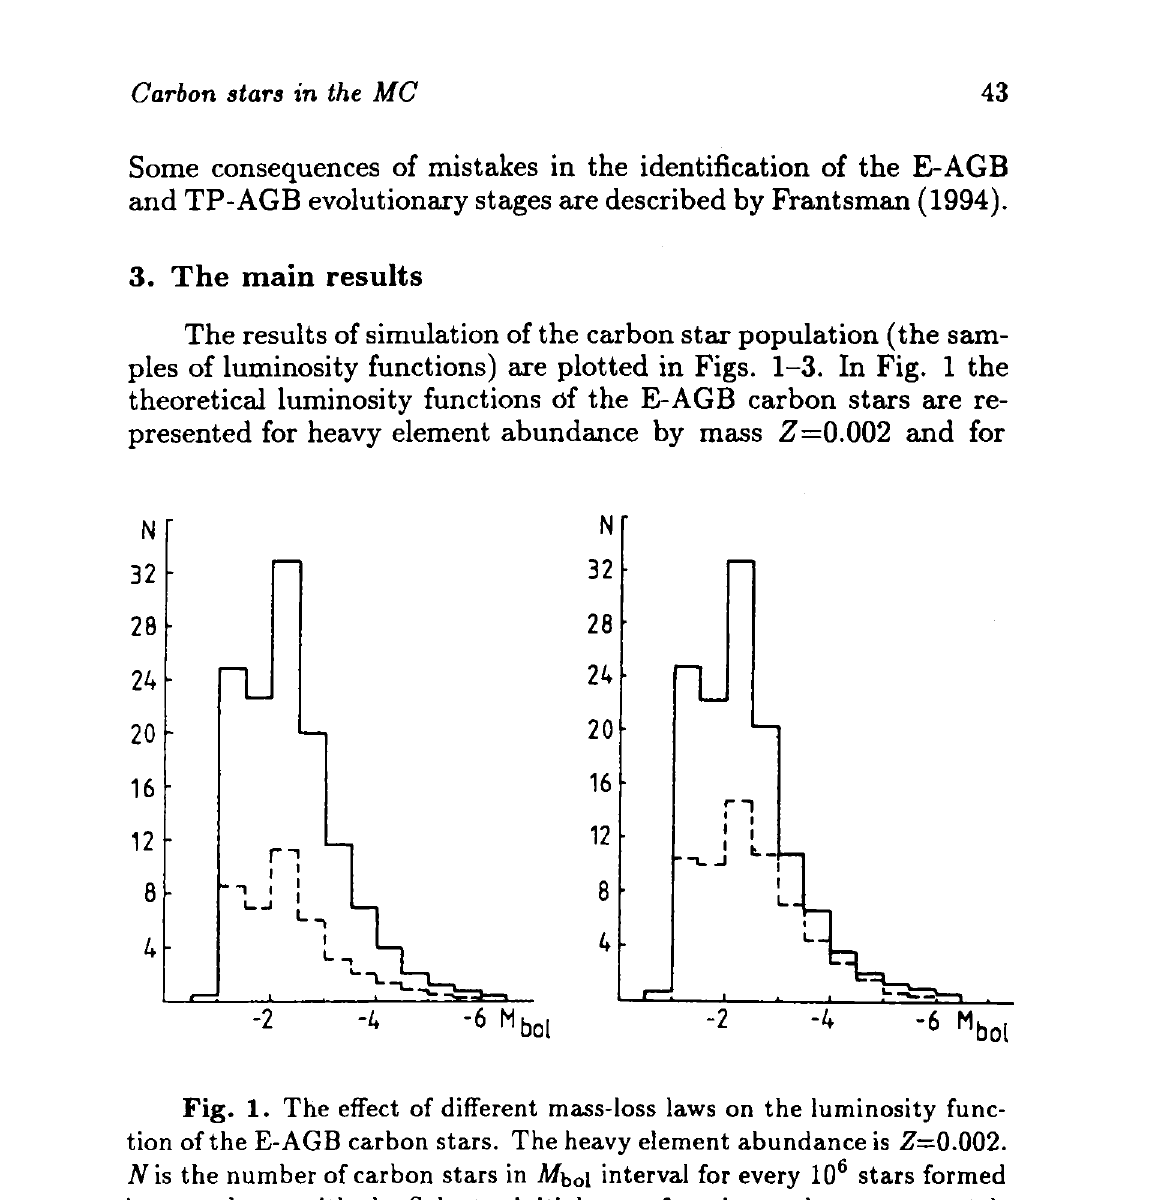
Fig. 1. The effect of different mass-loss laws on the luminosity func- tion of the E-AGB carbon stars. The heavy element abundance is Z~ 0.002. N is the number of carbon stars in A/bol interval for every 10 6 stars formed in accordance with the Salpeter initial mass function and a constant stel- lar birth-rate. The following values of the mass-loss coefficient a in the Reimer's law are accepted: the solid line is for a = l, the dashed line is for a = l, if Mbol > -5.5 mag, and a=10, if Mb l < -5.5 mag. 0